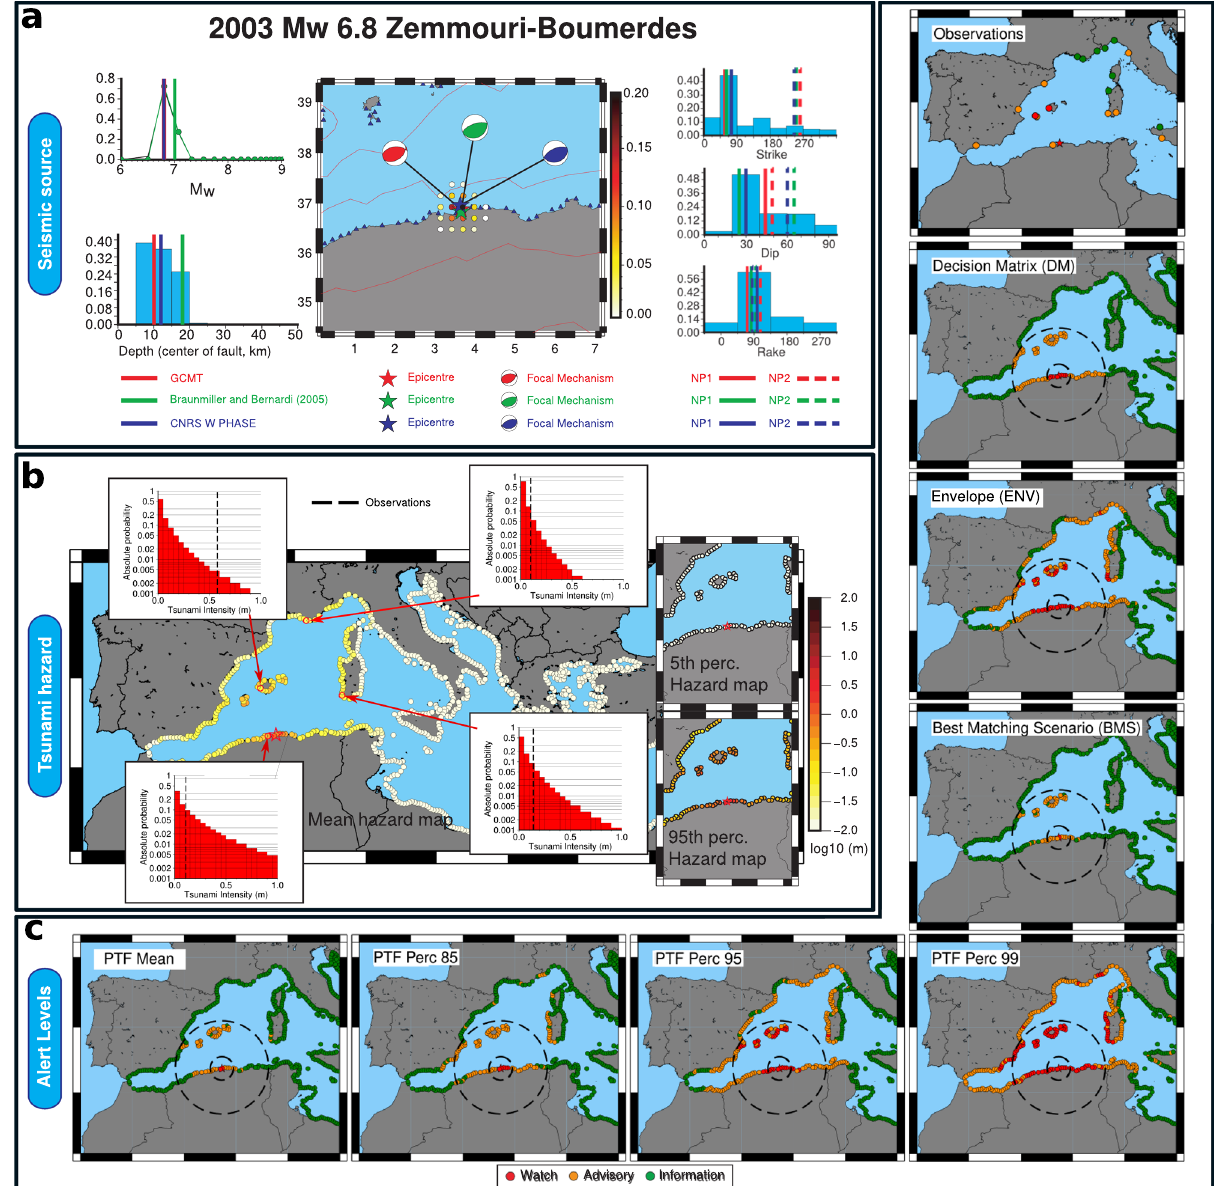
Fig. 2 PTF work fl ow: example for the 2003 Zemmouri-Boumerdes tsunami. a PTF source model: marginal distributions for earthquake magnitude and depth (left), location (centre), and fault parameters (right) for the ensemble describing source variability. Several revised moment tensor solutions are plotted as vertical lines for comparison. Distributions are consistent with seismic observations. For example, the ~30° southern-dipping realistic fault plane is strongly emphasized in the PTF source ensemble. b PTF results: tsunami intensity measure distribution (hazard curve) at four selected coastal locations in the western Mediterranean compared with observations (dashed vertical lines), and hazard maps involving all forecast points derived from different PTF ’ s statistics (mean, 5 – 95th percentiles), showing uncertainty and spatial pattern of the tsunami forecast. c NEAMTWS Alert levels assigned from observations 40 , decision matrix (DM), best-matching-scenario (BMS), envelope (ENV), and PTF mean, and 85, 95, and 99th percentiles; dashed lines indicate local and regional areas, as de fi ned in the DM (Supplementary Table 8). NEAMTWS considers three alert levels (Information, Advisory, and Watch), each corresponding to off-coast tsunami wave amplitudes intervals: alert levels are assigned comparing tsunami near-coast wave amplitude with alert-level